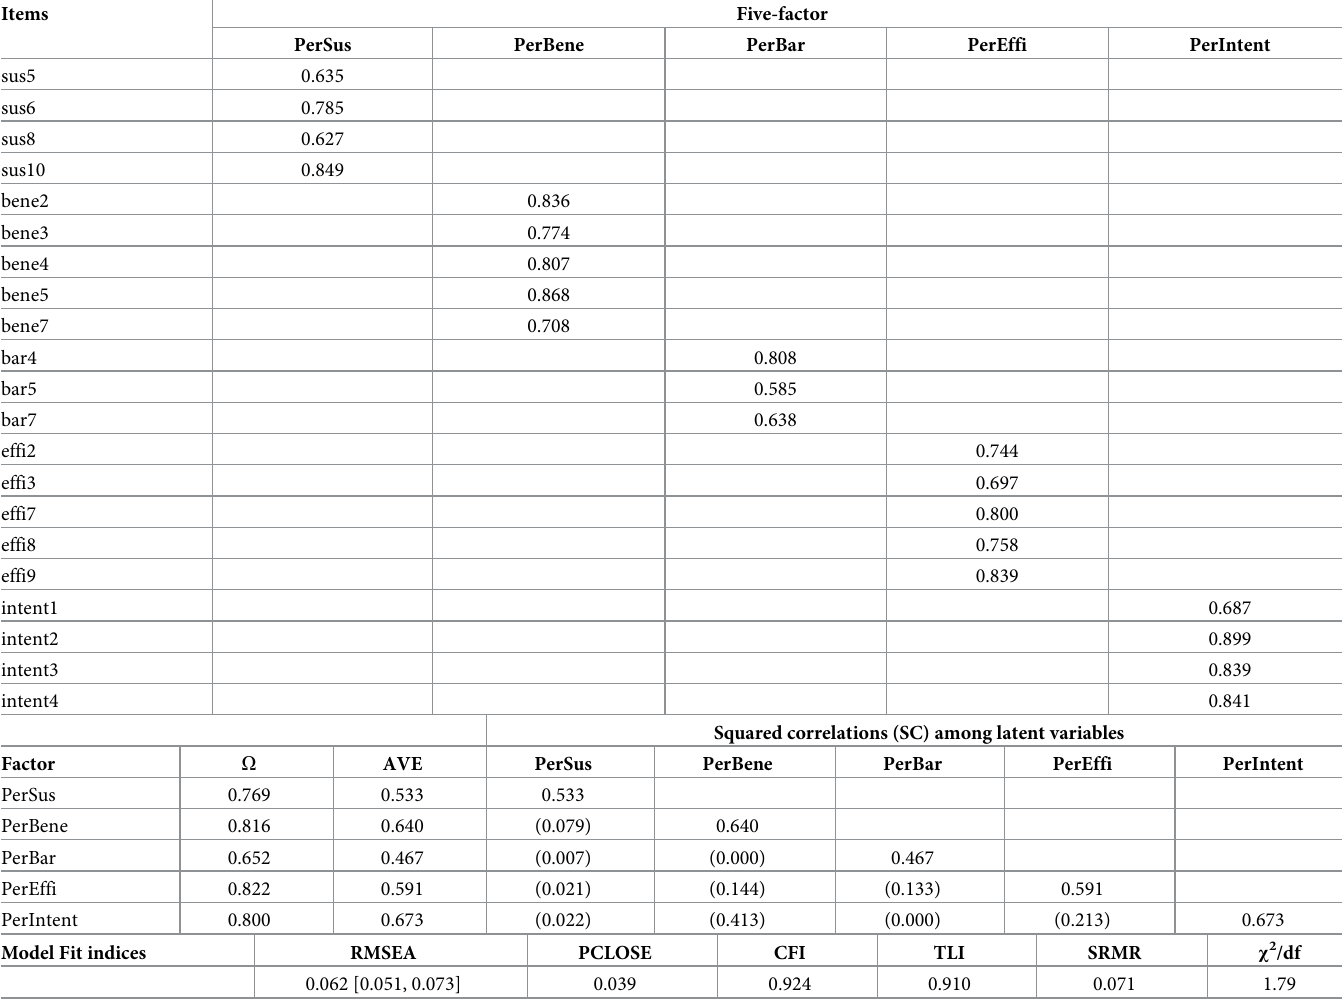
Table 3. Standardized factor loadings, convergent validity, discriminant validity, reliability, and model fit indices of CFA (Five-factor